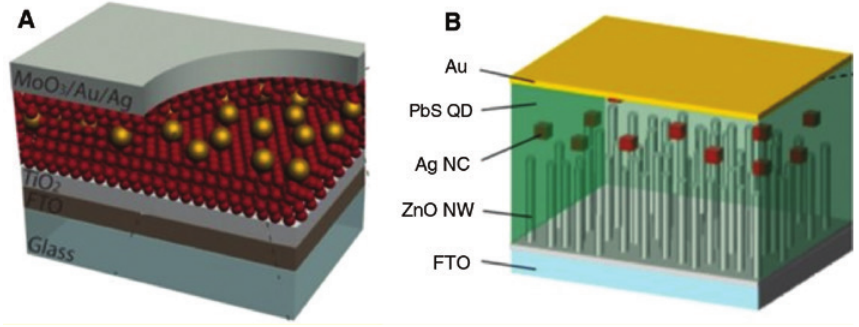
Figure 20: Schematic of typical device architectures of (A) planar colloidal quantum dot solar cells. Reprinted (adapted) with permission from [110]. Copyright 2015 American Chemical Society. (B) quantum dot bulk-heterojunction solar cells. Reprinted (adapted) with permission from [111]. Copyright 2013 American Chemical